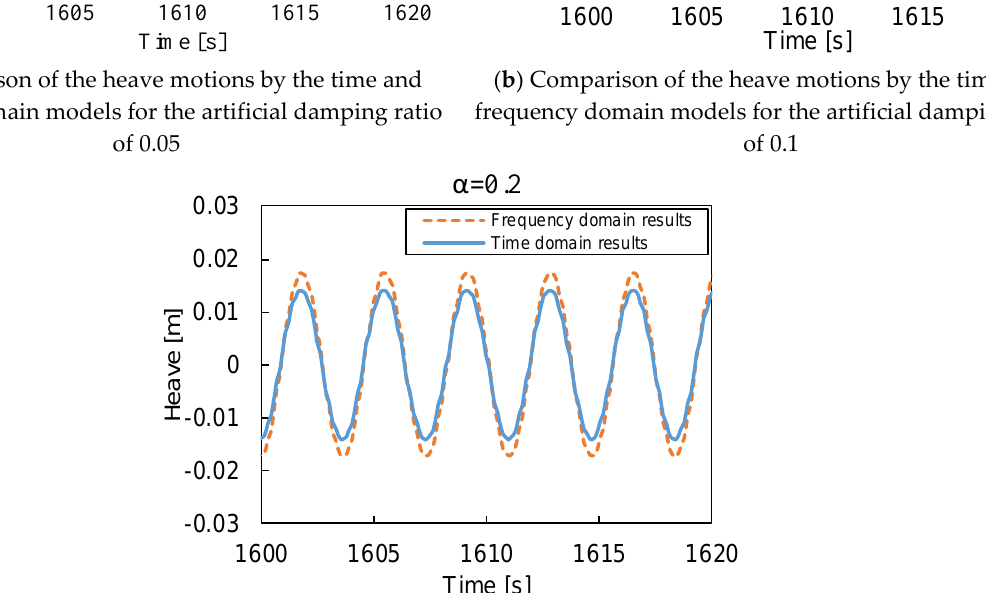
( c ) Comparison of the heave motions by the time and frequency domain models for the artificial damping ratio of 0.2 Figure 17. Heave response of the windward module in the frequency domain and time domain under different artificial damping α subjected to the regular wave ( H = 1 m, ω = 1.7 rad/s).